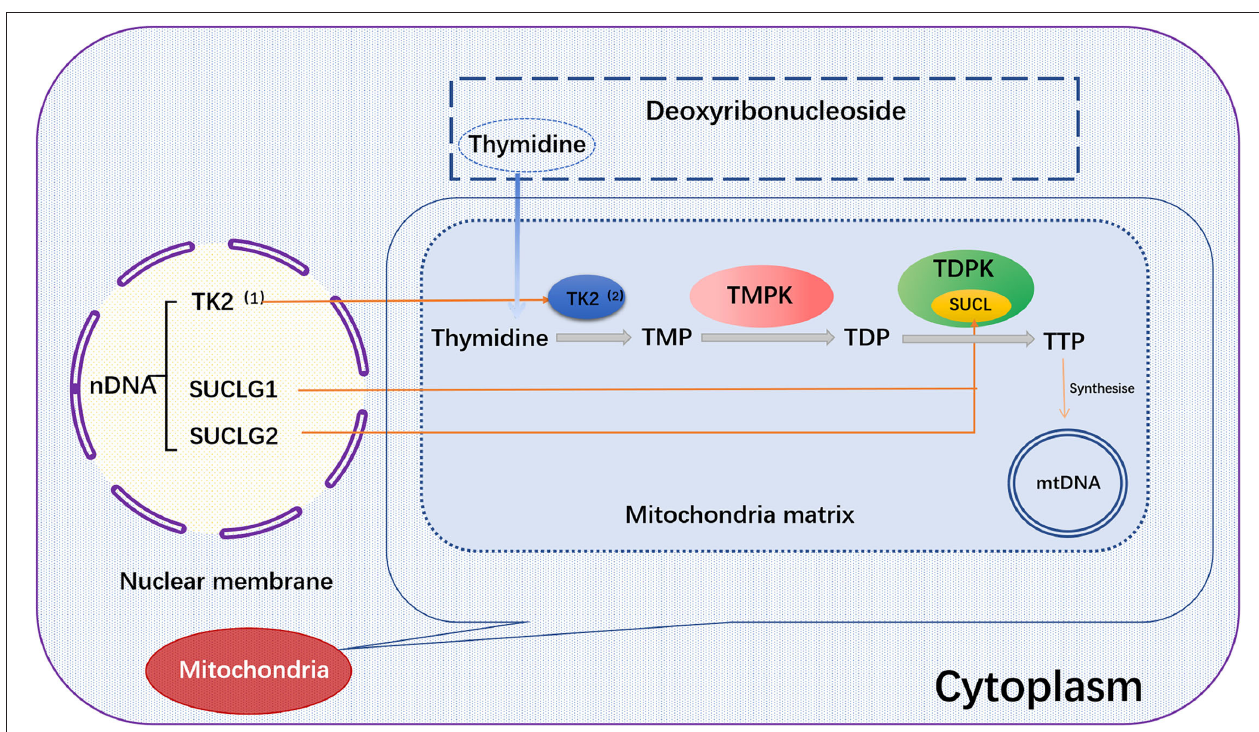
FIGURE 2 | TK2 , SUCLG1 , or SUCLG2 regulates mtDNA synthesis. In the salvage pathway, the pre-formed deoxyribothymidine enters the mitochondria. The deoxyribonucleoside is then catalyzed by the thymokinases TMPK and TDPK to phosphorylate the deoxyribonucleoside into the triphosphate form in the subsequent three phosphorylation steps, and further synthesize mtDNA. Among them, TK2 and TDPK are encoded by the nuclear genes TK2 and SUCLG1 / SUCLG2 , respectively. TK2 , (1) Thymidine Kinase 2, (2) Thymidine kinase; SUCLG1 , succinic acid A ligase α subunit; SUCLG2, succinate-CoA ligase GDP-forming β subunit; Thymidine, deoxyribosylthymine; TMPK, Thymidylate kinase; TDPK, Thiamine diphosphokinase; SUCL, Succinyl CoA ligase; TMP, Thymidine monophosphate; TDP, Thymidine diphosphate; TTP, Thymidine